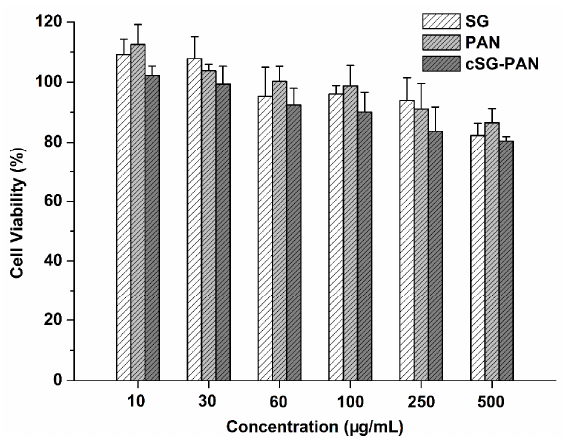
Figure 11. Survival percentage of A549 cells after treated with SG, PAN, and cSG-PAN nanofibers.